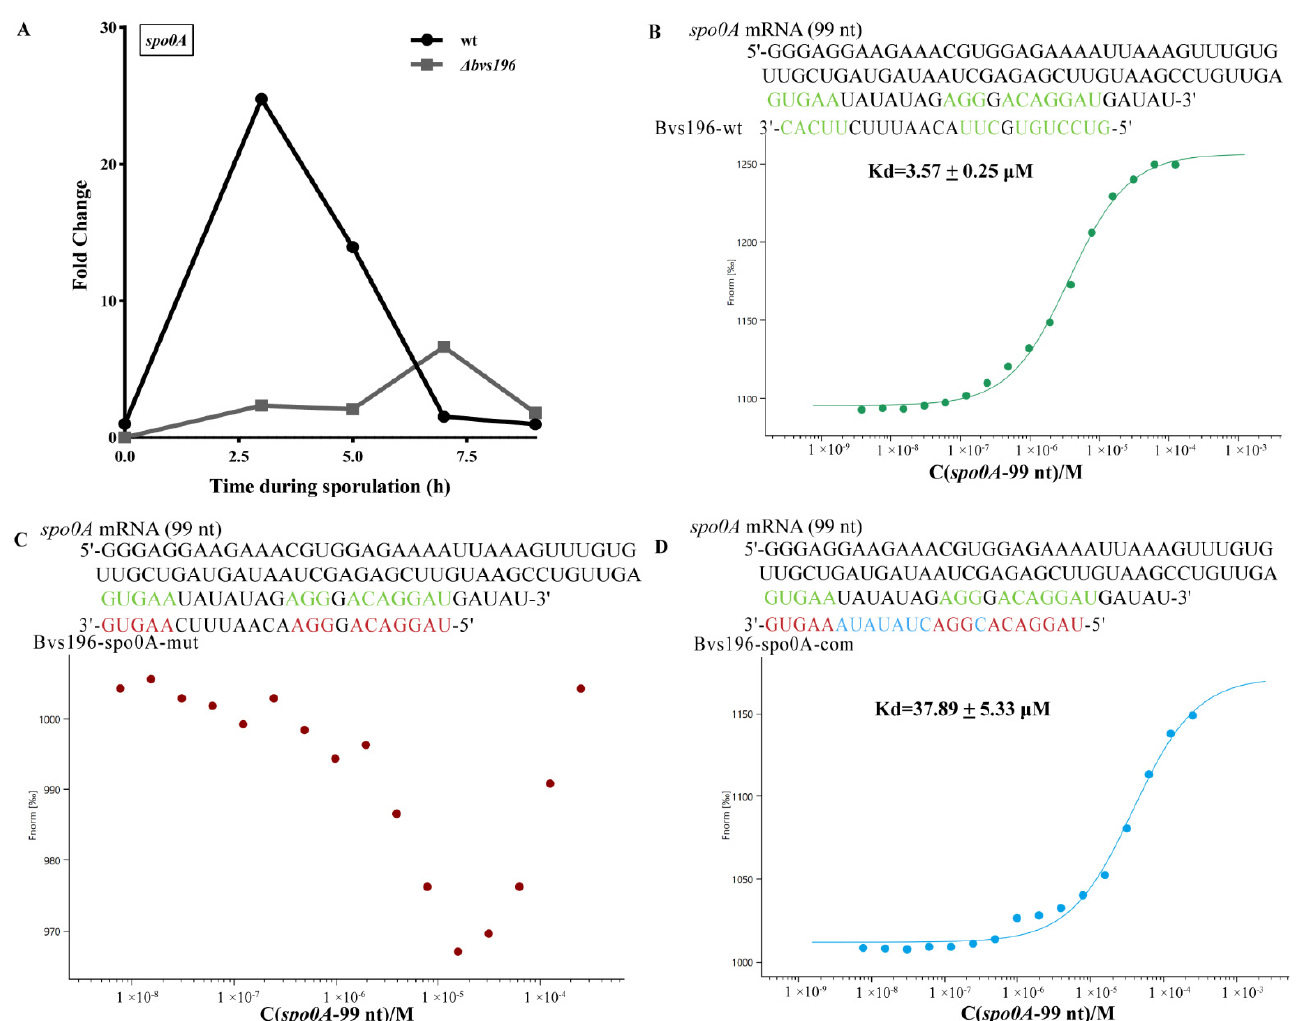
Figure 5. Transcriptional level of spo0A and the binding affinity of sRNA Bvs196 with spo0A by MST analysis in vitro. ( A ) temporal transcriptional expression of spo0A during sporulation in wt and Δ bvs196 . qPCR was used to calculate the relative expression levels of spo0A from wild-type (wt)- and ∆ bvs196 strain-induced sporulation by RM medium at 37 ◦ C. Time shown is hours after resuspension in RM medium, and the relative expression levels are represented as the fold change to wt at t = 0. Data shown is averages from triplicates. ( B – D ) Paired bases are shown in green. Point mutations are shown in red and blue. The Kd value reflects the binding affinity between two molecules; wt indicates wild type; mut indicates mismatch mutation; com indicates compensatory mutation. ( B ) spo0A mRNA (99 nt)/Bvs196-wt, the green curve; ( C ) spo0A mRNA (99 nt)/Bvs196-spo0A-mut, the red curve; and ( D ) spo0A mRNA (99 nt)/Bvs196-spo0A-com, the blue curve.